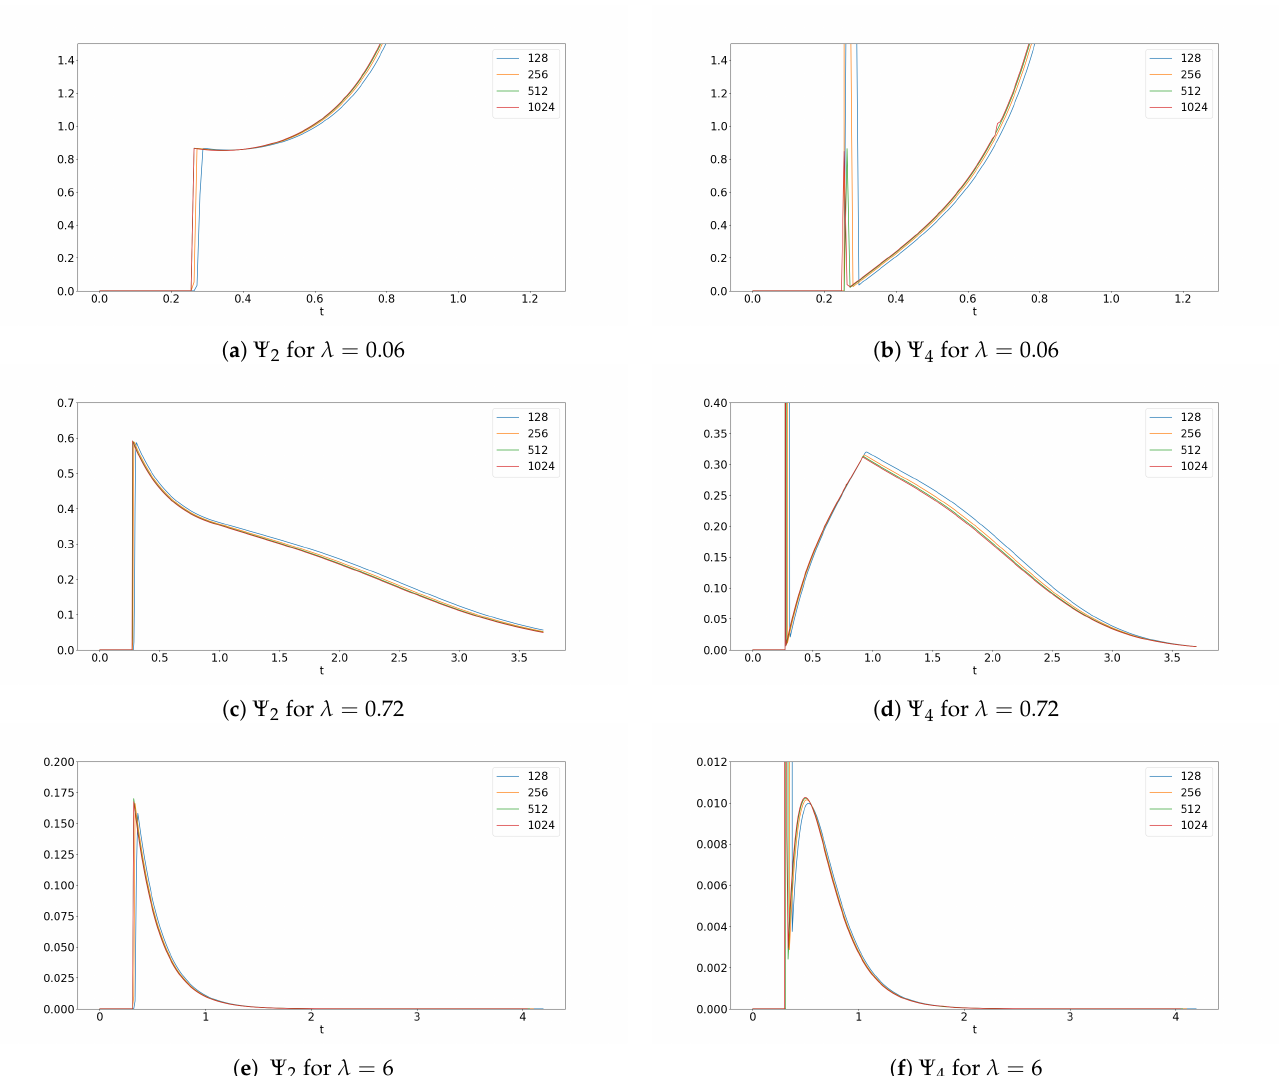
Figure 16. Plots along u = v equiv. z = 0 of Ψ 2 and Ψ 4 as a → ∞ with λ = 0.6, 0.72 and 6.